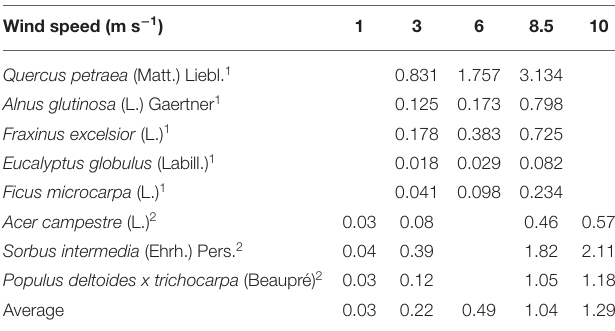
TABLE 1 | Deposition velocities for different wind-speed classes for deciduous broadleaved trees derived from published data.